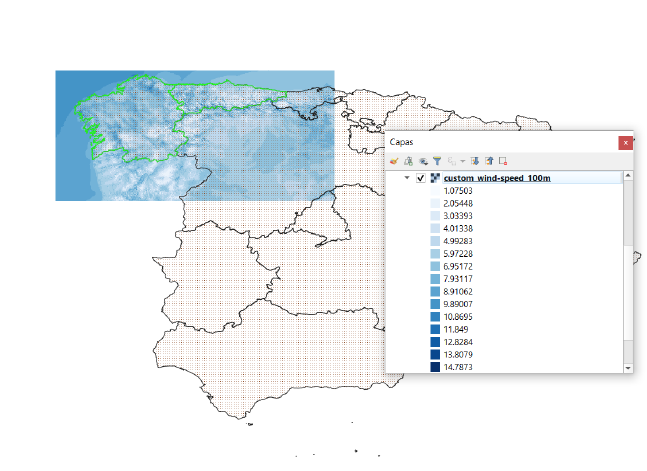
Figure 16. Global Wind Atlas: Wind speed (m/s) at 100 m. Own elaboration.